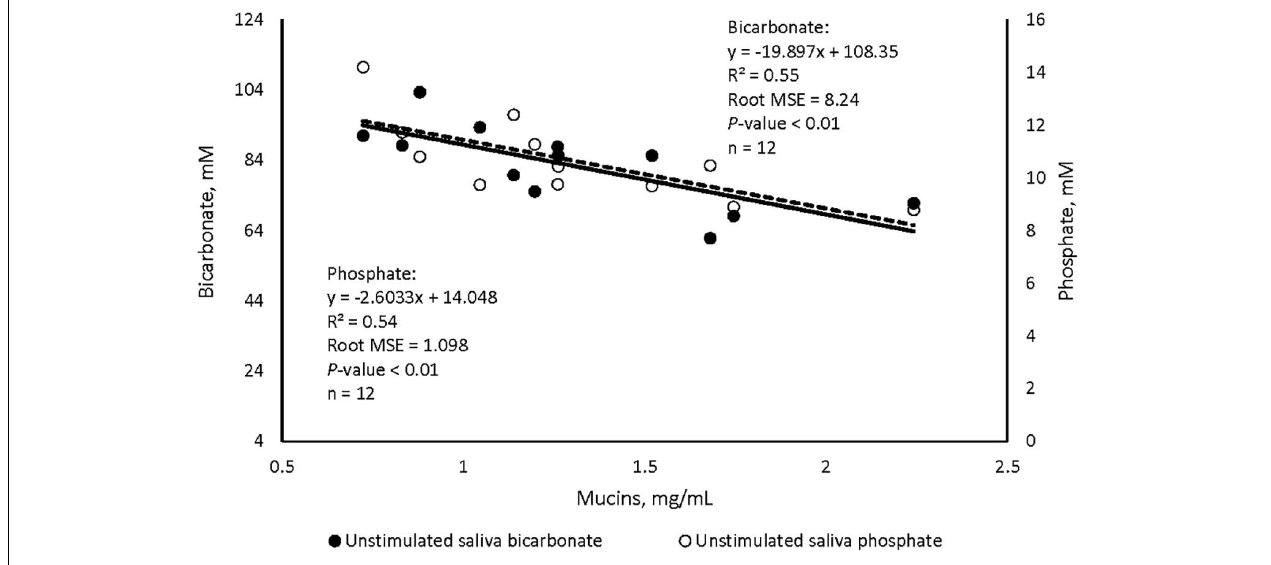
), and phosphate (- -) in the unstimulated salivary (cid:32) (cid:35) Treatment 1 P -value